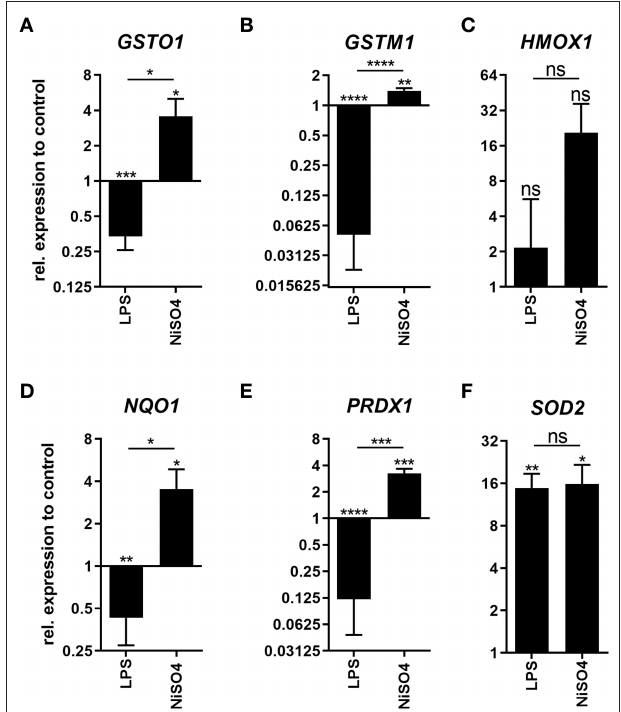
FIGURE 2 | Expression of Nrf2-target genes in LPS- and NiSO 4 -treated MoDCs. Depicted is the gene expression of glutathione S-transferase omega (GSTO1, A ), glutathione S-transferase mu (GSTM1, B ), heme oxygenase (HMOX1, C ), NAD(P)H dehydrogenase (NQO1, D ), peroxiredoxin (PRDX1, E ) and superoxide dismutase (SOD2, F ) as measured by the qRT-PCR after treatment of MoDCs with medium only, 2.5 µ g/ml LPS or 400 µ M NiSO 4 for 24h. Gene expression was normalized to the gene expression of the housekeeping gene HPRT and medium control. Thereof, mean and SD are shown ( n = 3 donors). Applying the Student’s t -test, significance was calculated to medium control (* p -value ≤ 0.05; ** p -value ≤ 0.01; *** p -value ≤ 0.001; **** p -value <